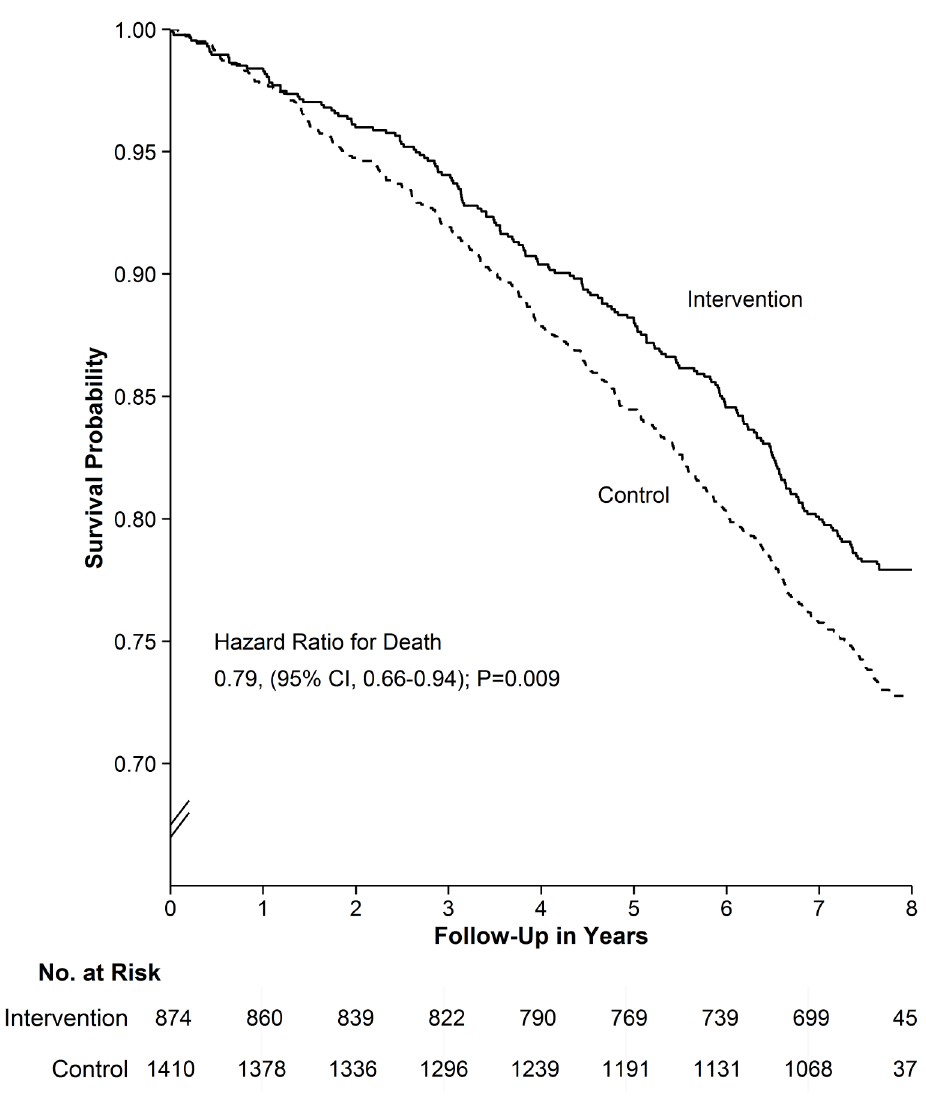
Fig 2. Probability of survival. The primary outcome at 8-y follow-up was all-cause mortality. Based on Kaplan-Meier estimates of survival.